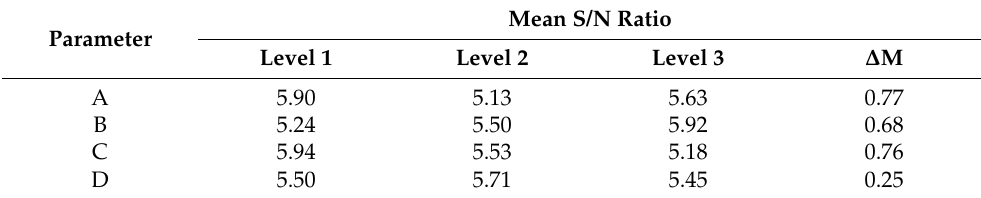
Table 13. S/N response for coefficient of